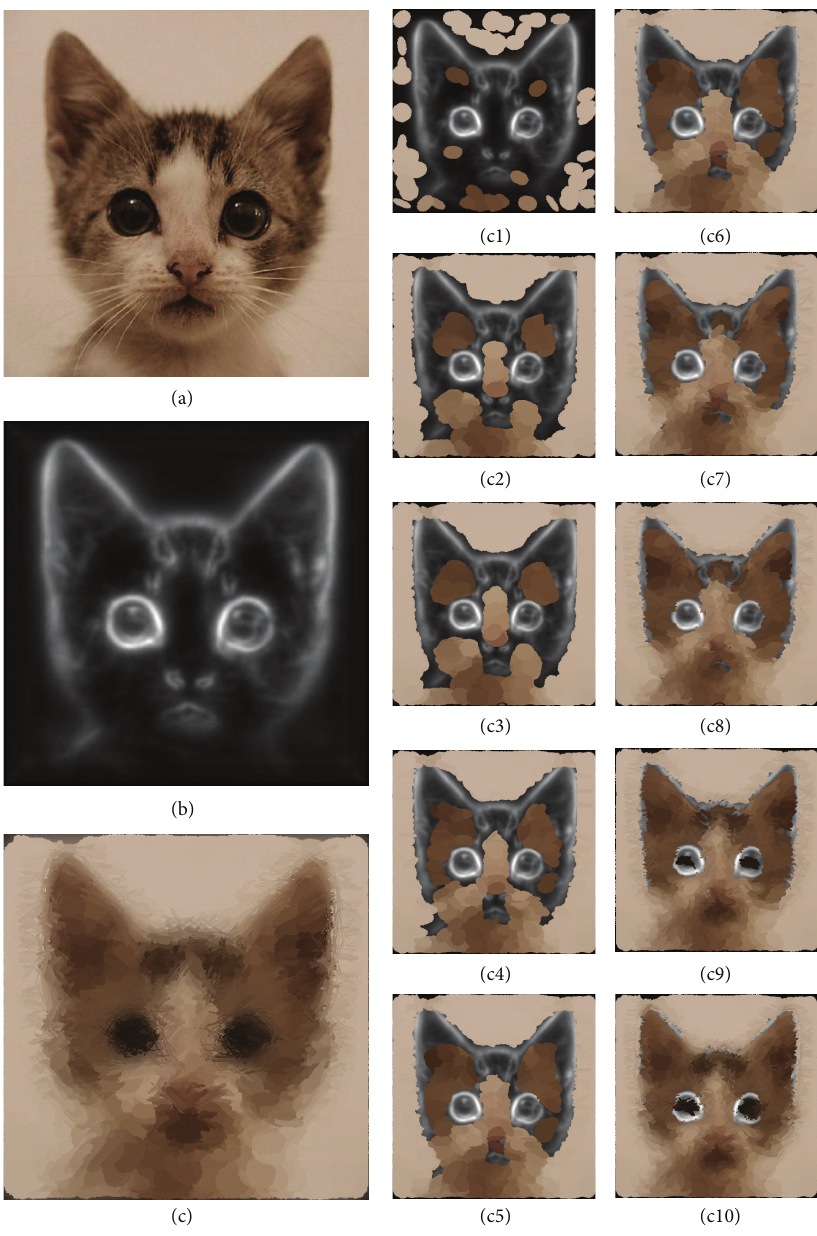
Figure 3: Dot-placement strategy and rendering process: from large dots to small dots, from nonsalient areas to salient areas, one by one, layer-by-layer. (a) Source image; (b) saliency image; (c) final Pointillism with 10000 dots; (c1) ∼ (c10) rendering process from 100 dots to 1000 dots, 2000 dots until 9000 dots, taking the saliency image as canvas image so as to check the placement strategy. In real rendering process, the blurred source image is taken as a canvas